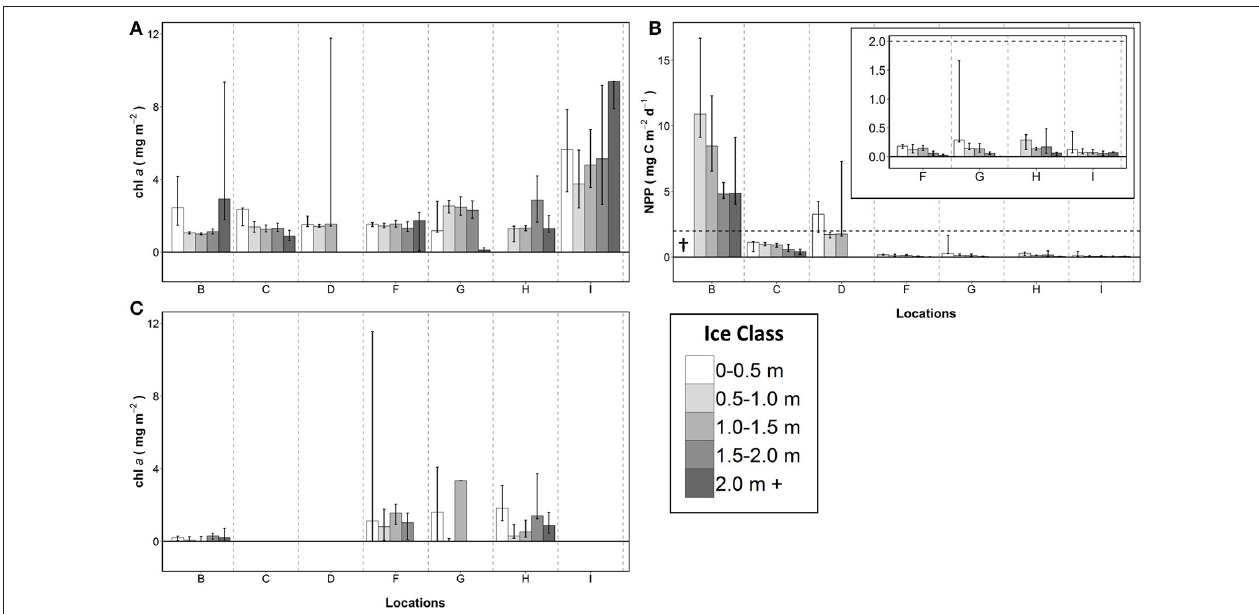
FIGURE 5 | Summary of chlorophyll a and NPP estimates per ice class and location for: (A) ROV derived chlorophyll a biomass; (B) ROV-derived NPP estimates; and (C) SUIT derived chlorophyll a biomass estimates. Bars represent median and error bars the interquartile range. † Indicates missing values.